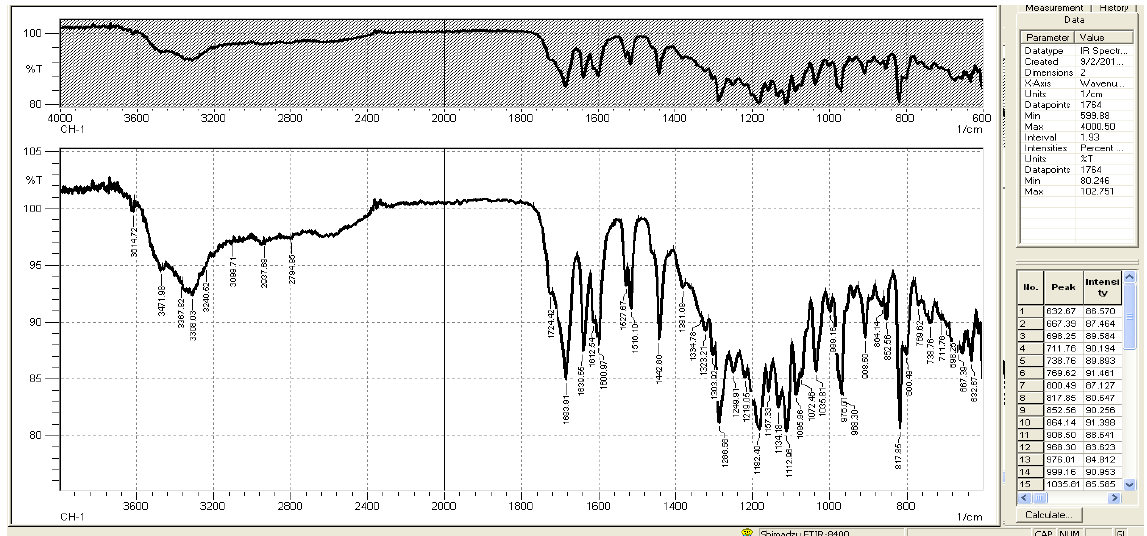
Figure12. FTIR spectrum of isolated chlorogenic acid. FTIR spectral analysis of isolated caffeic acid (compound show peaks at 3400, 3250- 3200,